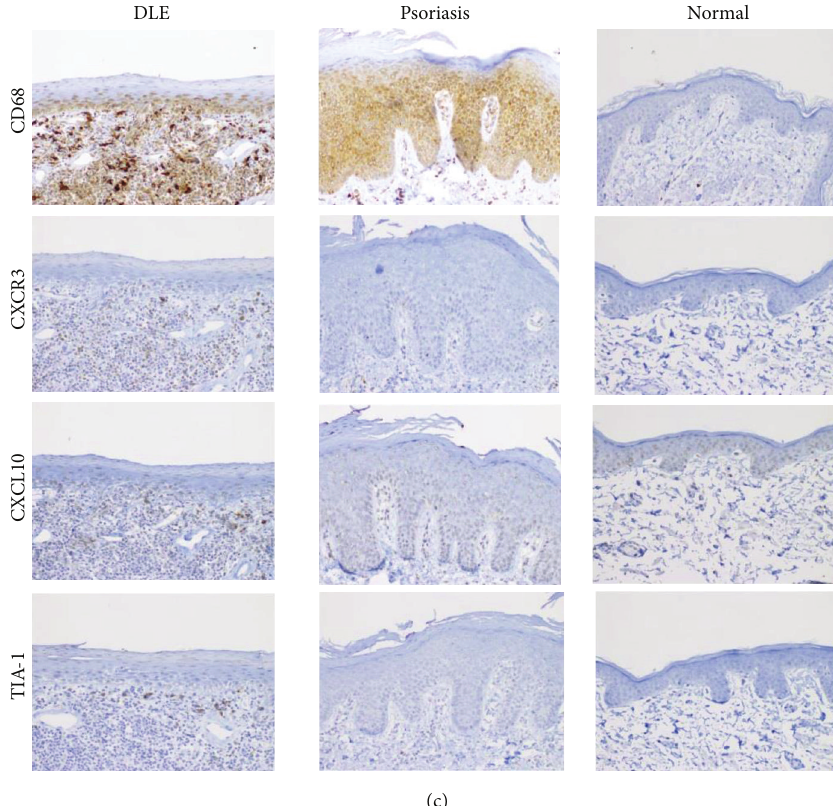
Figure 1: Comparisons of staining of T cell, B cell, and macrophage markers (CD3, CD4, CD8, CD20, CD68, CXCR3, CXCL10, and TIA-1) in the epidermis and dermoepidermal junction (DEJ) of DLE lesional skin ( 𝑁 = 23 ), psoriasis lesional skin ( 𝑁 = 11 ), and normal skin ( 𝑁 = 5 ). (a) The epidermis of psoriasis lesional skin contained higher levels of CD3 + and CD4 + T cells than DLE lesional skin. (b) The DEJ of DLE lesional skin expressed higher amounts of CD3 + T cells, CD8 + T cells, and CD68 + macrophages than psoriasis lesional skin and normal skin and higher amounts of CD4 + T cells, CD20 + B cells, and TIA-1 versus at least one of the control populations studied. ∗ 𝑃 < 0.01 ; ∗∗ 𝑃 < 0.001 ; ∗∗∗ 𝑃 < 0.0001 . (c) H&E and various immunostainings showed that the epidermis of psoriasis lesional skin contained higher levels of CD3 + and CD4 + T cells, while the DEJ of DLE lesional skin expressed higher amounts of CD3 + T cells, CD8 + T cells, and CD68 + macrophages. Magnification: